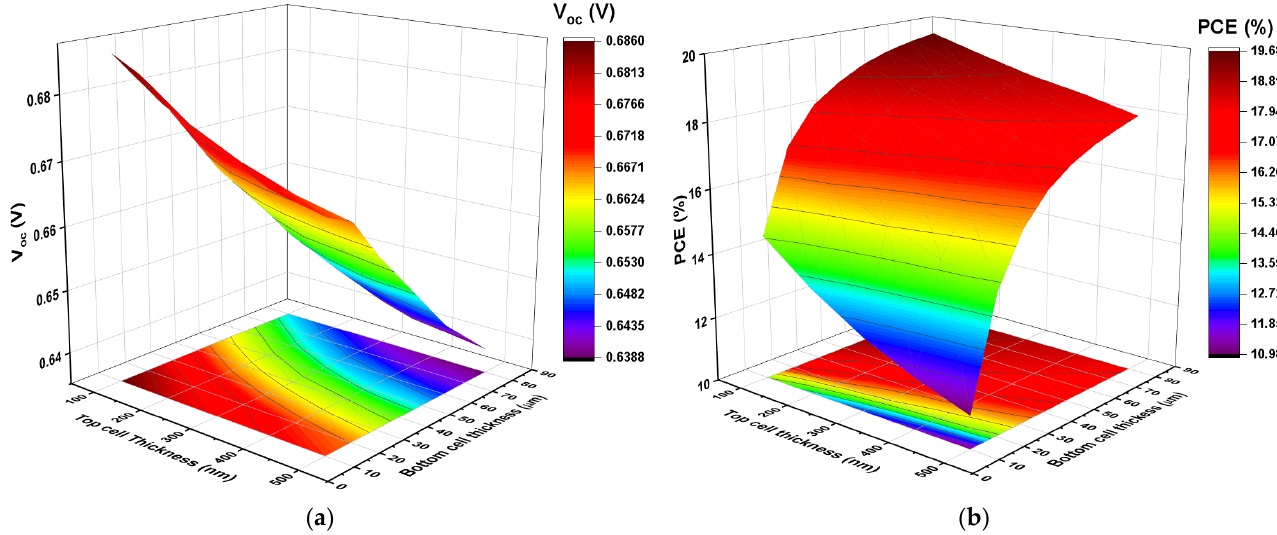
Figure 13. The 3D contour plot of PV parameters for the bottom cell: ( a ) V oc and ( b ) PCE at different thicknesses of the absorber layer in the top and bottom cells.